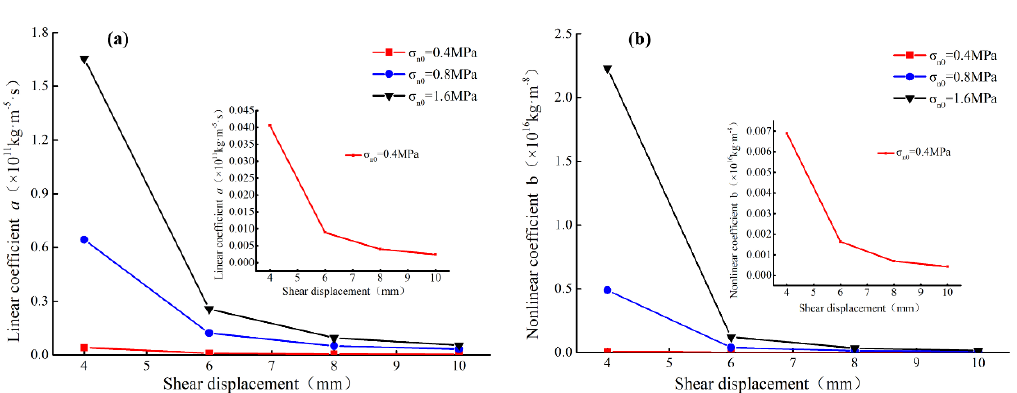
Figure 6. Relationship between coefficients of Forchheimer equation and shear displacement under different initial normal stresses, ( a ) linear coefficient a; ( b ) nonlinear coefficient b.